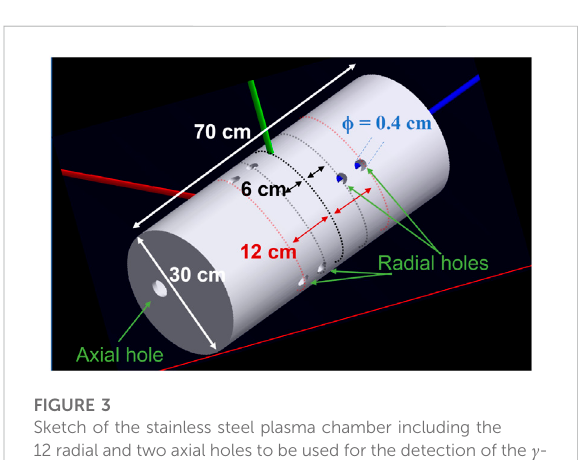
FIGURE 3 Sketch of the stainless steel plasma chamber including the 12 radial and two axial holes to be used for the detection of the γ - rays; quotations of hole displacement along the lateral chamber walls are